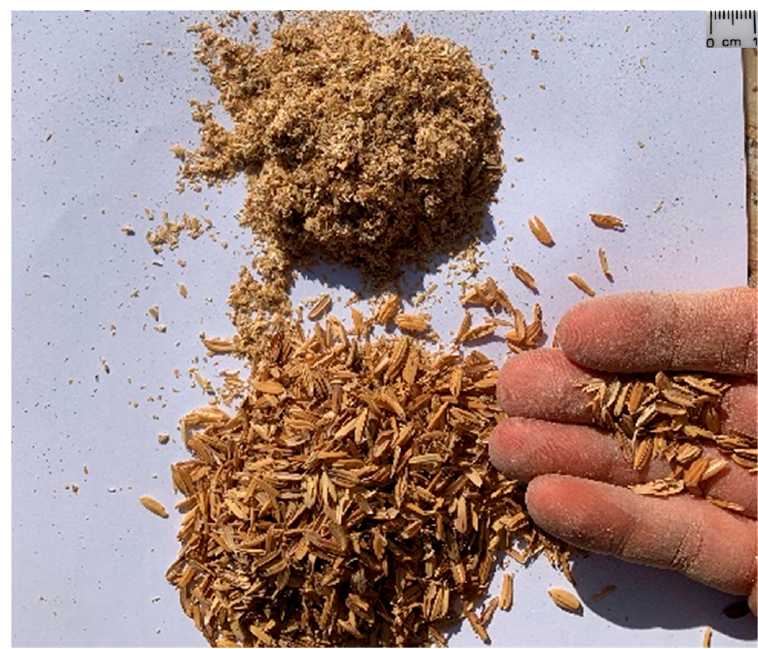
Figure 1. The two types of RH used in the experimental program, arranged by decreasing lengths from bottom to top: unaltered RH (maximum size variable from 6 to 8 mm), and shredded RH (maximum size: 2 mm).